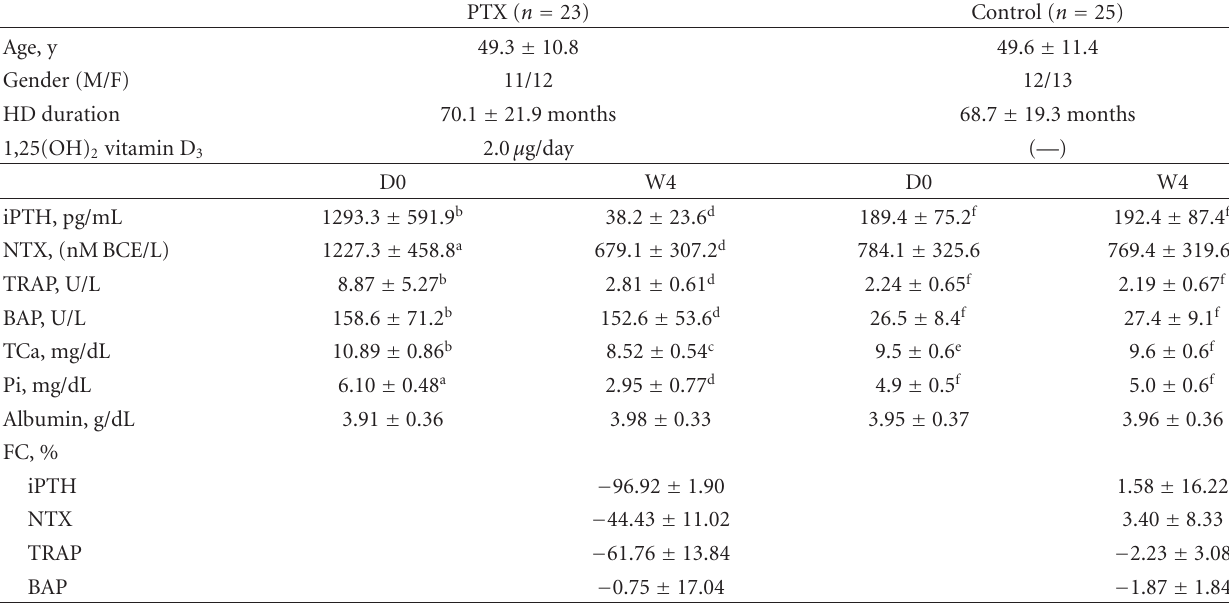
Table 1: Clinical variables and biochemical parameters for the control group and for the parathyroidectomy (PTX) group before and 4 weeks after the